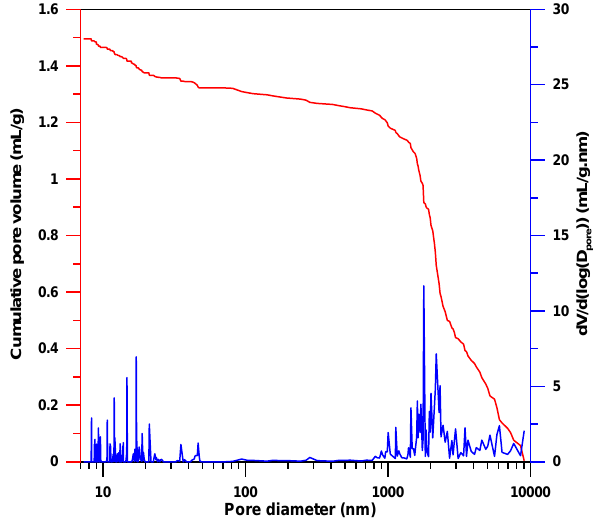
Figure 2. Pore diameter distribution of PolyHIPE membrane (30 wt % St, 60 wt % EHA, and 10 wt % DVB).